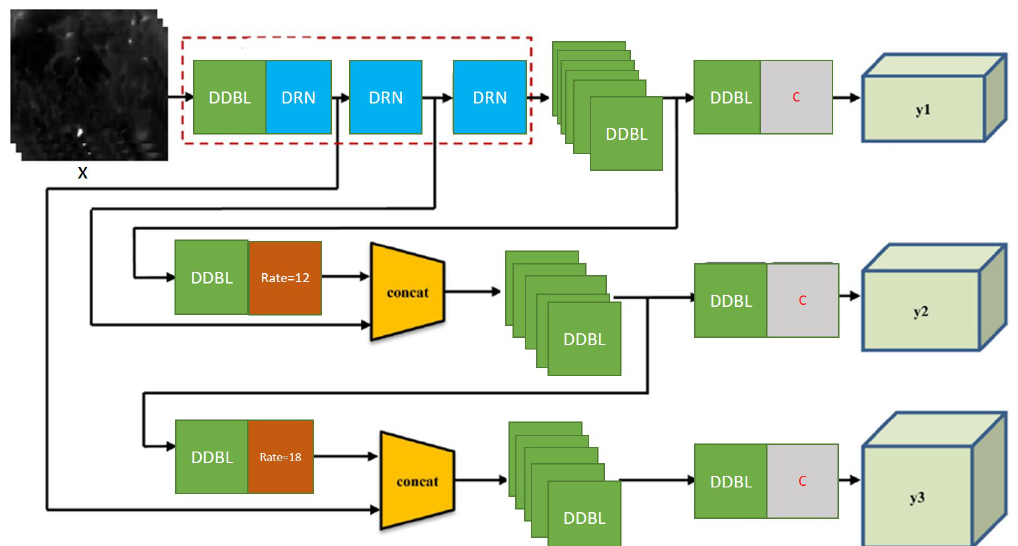
Figure 6. D-YOLO architecture with input image size 416 × 416 pixels and 3 types of feature map (13 × 13 × 3, 26 × 26 × 3, and 52 × 52 × 3) as output; DDBL stands for Darknet dilated conv2D BN Leaky, composed of one convolution layer, one batch normalisation layer, and one leaky relu layer.; DRN (Dilated Residual Network) provides residual-like connection with dilated convolutions. Similarly, for multiscale spatial pooling, we use different dilation rates and replace upsampling with dilation